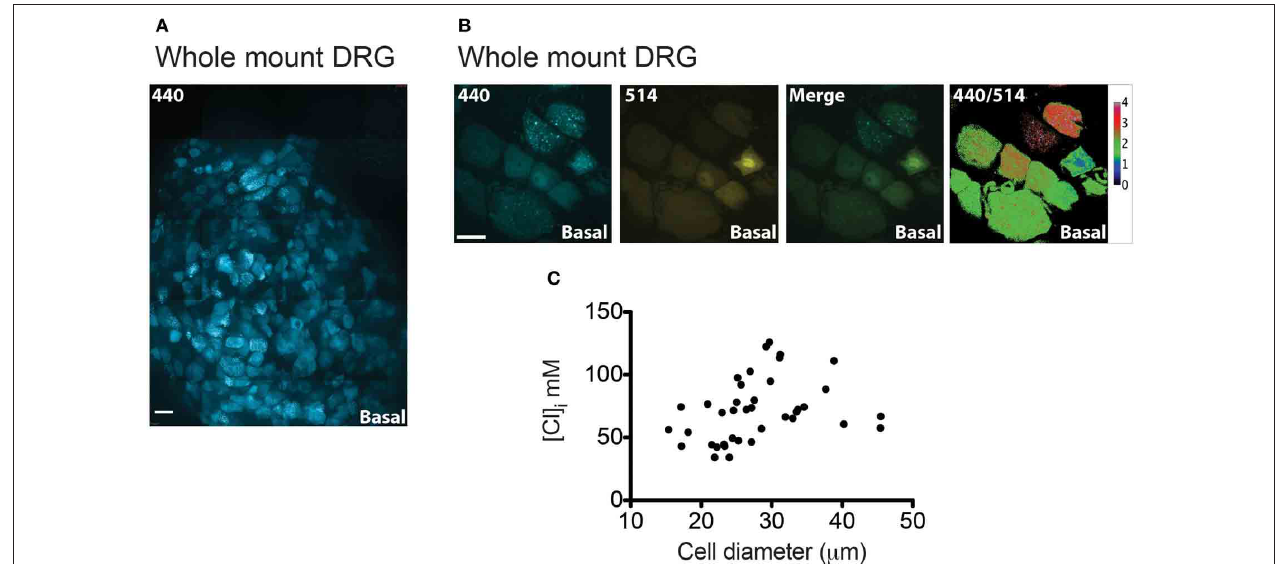
conditions used for [Cl] i measurement. From left to right: image captured with the 440nm laser (blue), 514nm laser (yellow), and 440/514 images. Scale bars correspond to 20 μ m. (C) The relationship between cell size and [Cl] i in DRG neurons from a whole mount preparation n =